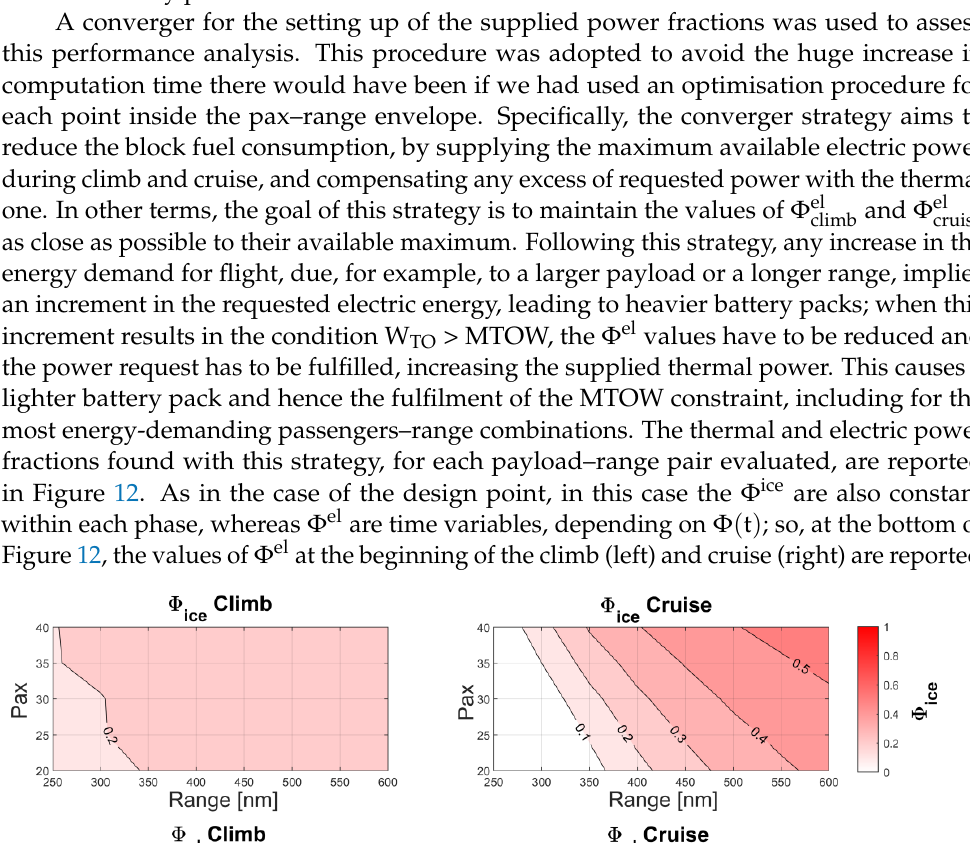
Figure 12. Thermal (top) and electrical (bottom) supplied power fractions in climb (left) and cruise (right) for the missions inside the pax – range diagram.